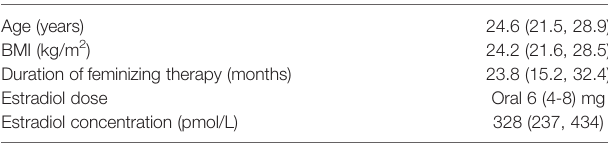
TABLE 3 | Clinical Characteristics (<45 years age group).